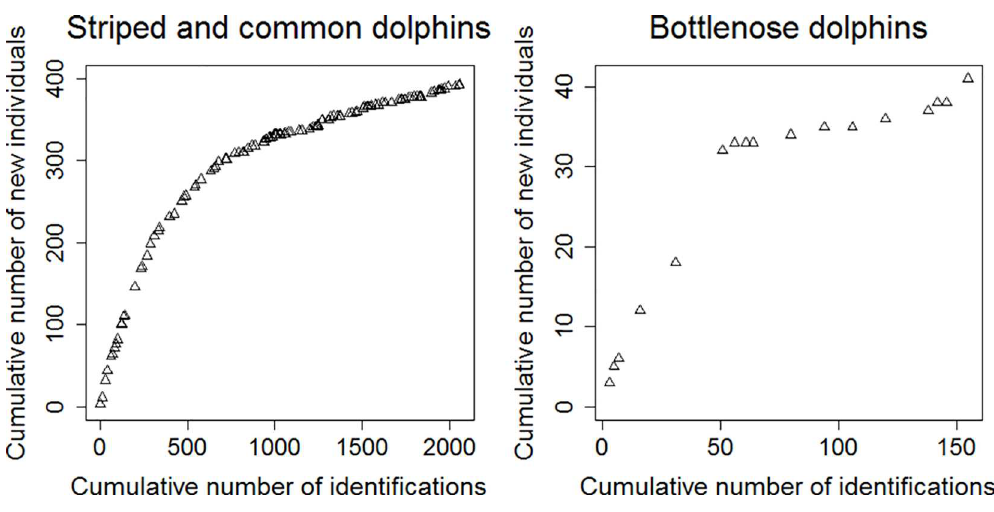
Fig 2. Rate of discovery of new D1 individuals over time for the two photo-identification datasets.